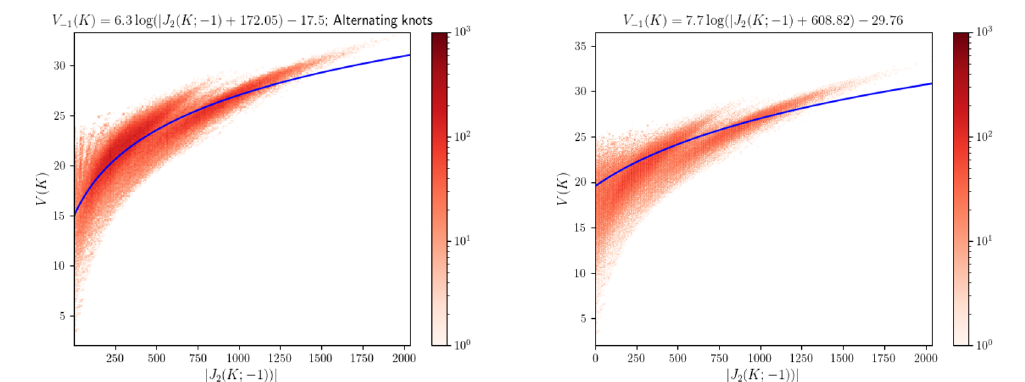
Figure 6 . Comparison of (4.1) with a fit of the same functional ansatz on J 2 ( K ; − 1) ; as in [14]. When applied to alternating knots only (left), the function predicts the volume with a mean error of 5 . 76% . Fitting the same ansatz to all knots (right) predicts the volume with an error of 6 . 16% . a log( | J ( K ; − 1) | + b )+ c for alternating and non-alternating knots (figure 6). For knots up 2